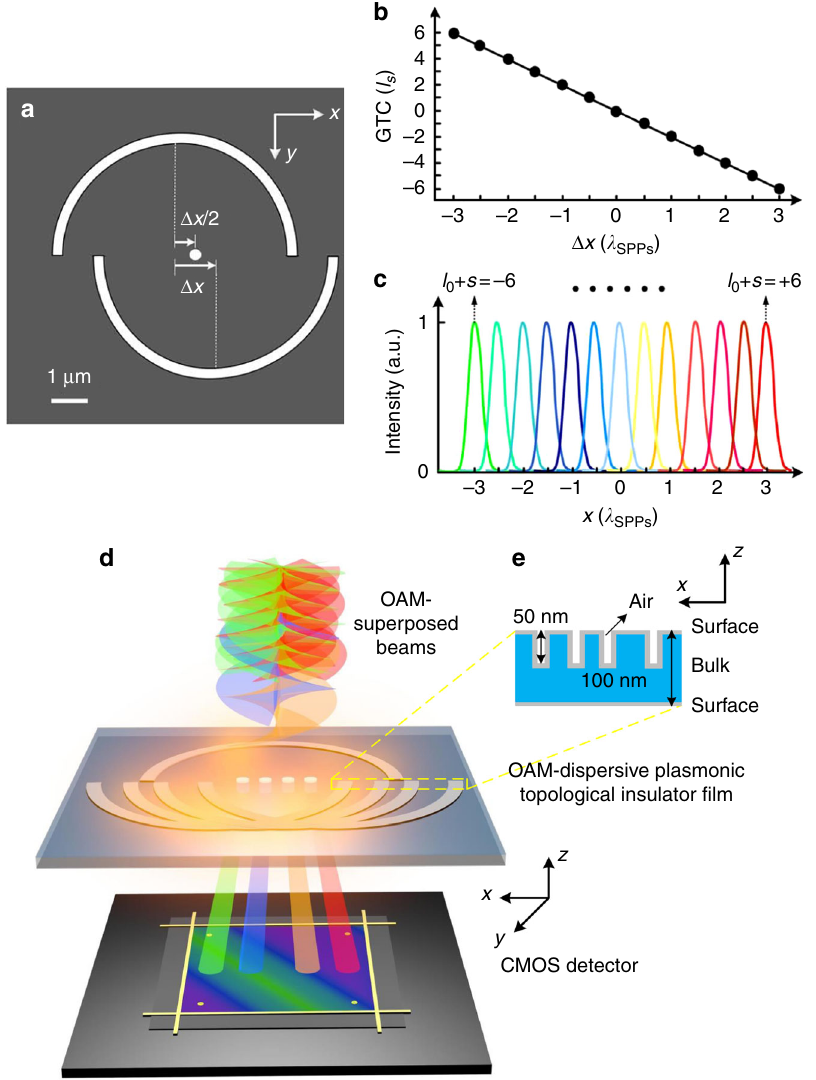
Fig. 1 Principle of OAM nanometrology in a plasmonic topological insulator fi lm. a The schematic design of different GTCs by shifting one half of a circular nanogroove with respect to the other along the breaking line. The GTCs are inspected in the middle of the transverse shifts ( Δ x /2), where Δ x is the shifting distance. b The linear dependence of the GTC ( l S ) on the transverse shift ( Δ x ) of the two semi-circular nanogrooves. λ SPPs represents the SPPs wavelength. c The intensity cross-sections in the transverse shift direction (the x -axis) of plasmonic fi elds excited by illuminating optical beams with incident angular momentum modes ( l 0 + s ) ranging from − 6 to + 6 on displaced semi-circular nanogrooves with the GTCs ( l S ) ranging from + 6 to − 6, respectively. d The schematic of CMOS-integratable OAM nanometrology. An ultrathin OAM-dispersive plasmonic topological insulator fi lm is constituted by spatially shifted semi-circular nanogrooves and mode-sorting nanoapertures, through which the OAM-superposed beams are spatially separated and directly measured by a CMOS detector in the far- fi eld region. e The multilayer structure of the topological insulator thin fi lm as well as the cross-section of